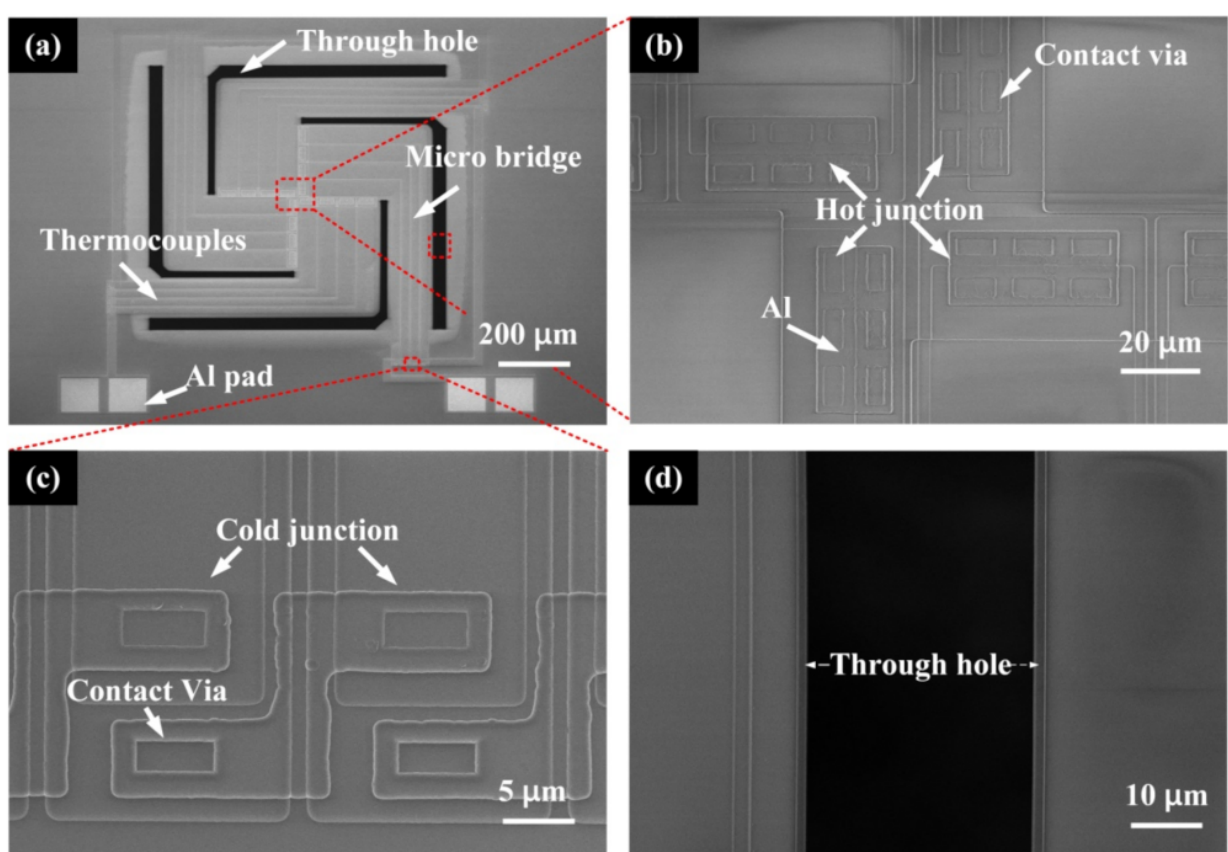
Figure 4. SEM images of ( a ) an MB-based thermopile, ( b ) hot junctions of the device, ( c ) a group of cold junctions in the device, and ( d ) an amplified image of a through-hole.